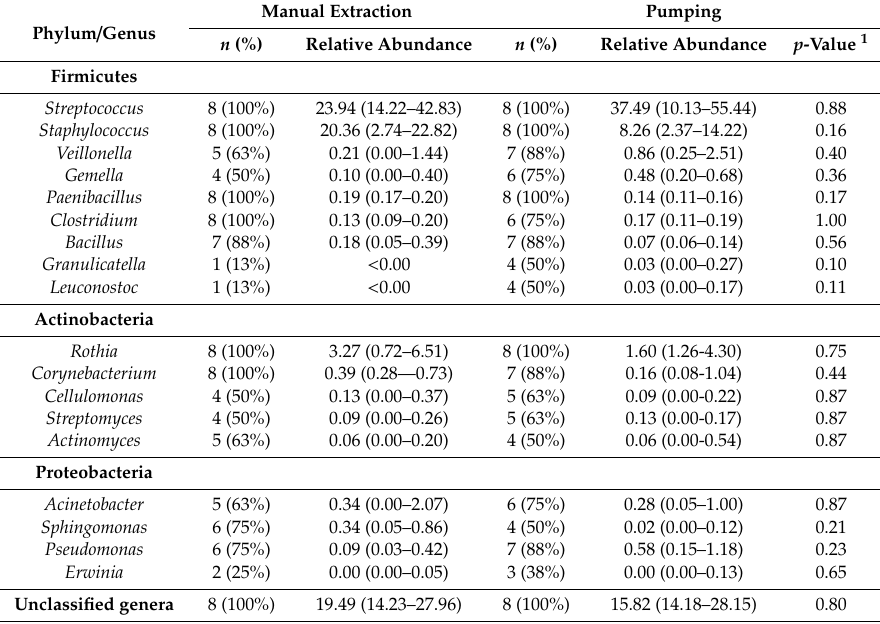
Figure 3. ( A ) Comparison of the relative abundance of sequences (%) belonging to main bacterial phyla obtained by metataxonomic analysis from milk samples obtained using a pumping device (blue) or by manual expression (yellow). ( B ) Individual profile of the relative abundance of the most abundant phyla in the milk samples provided by each woman ( n = 8; W_1 to W_8) using two collection methods: manual expression (M) or using a pumping device (P). Table 3. Relative abundance (%), expressed as the median and the interquartile range, of the 20 most abundant genera depending on the milk extraction method (manual expression or pumping).